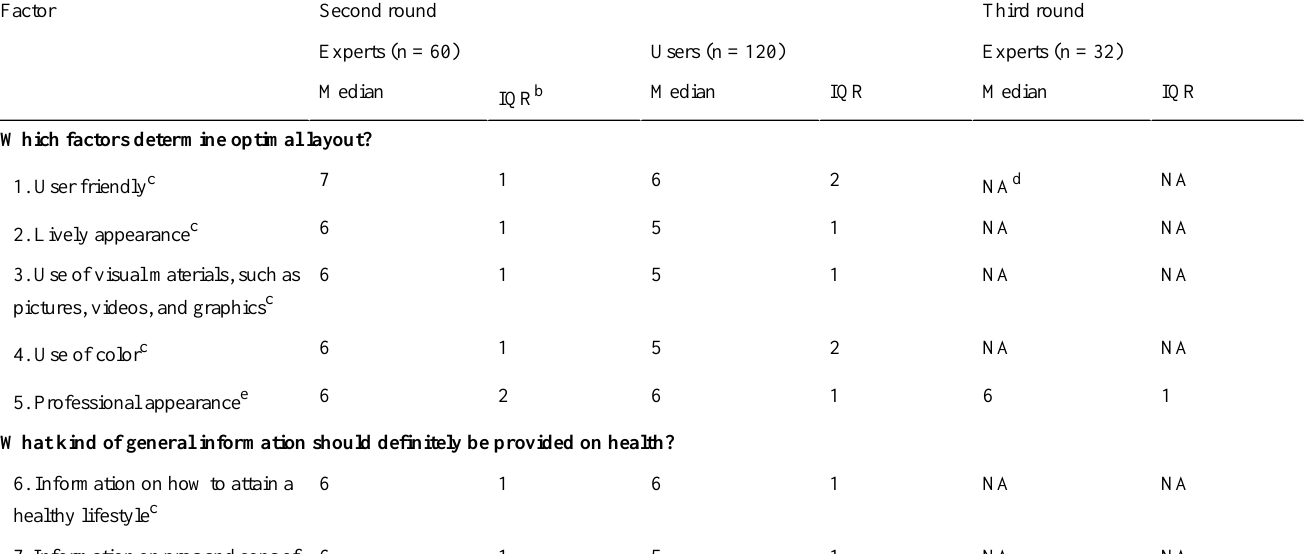
Table 3. Median scores for important factors in health-related Internet sites on which consensus was obtained by experts, potential users, or botha